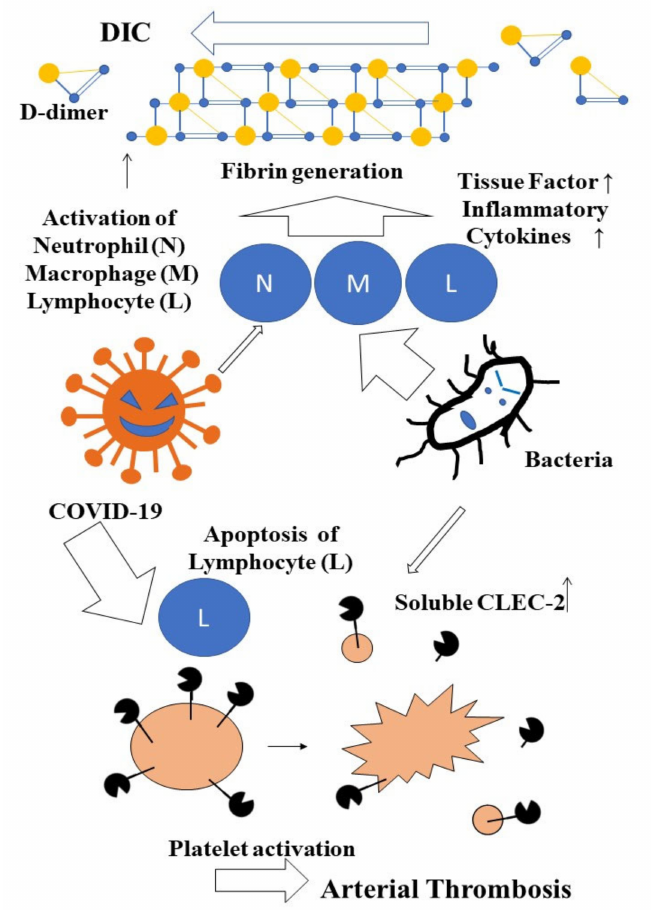
Figure 4. Difference of sCLEC-2 and D-dimer levels between COVID-19 and bacterial